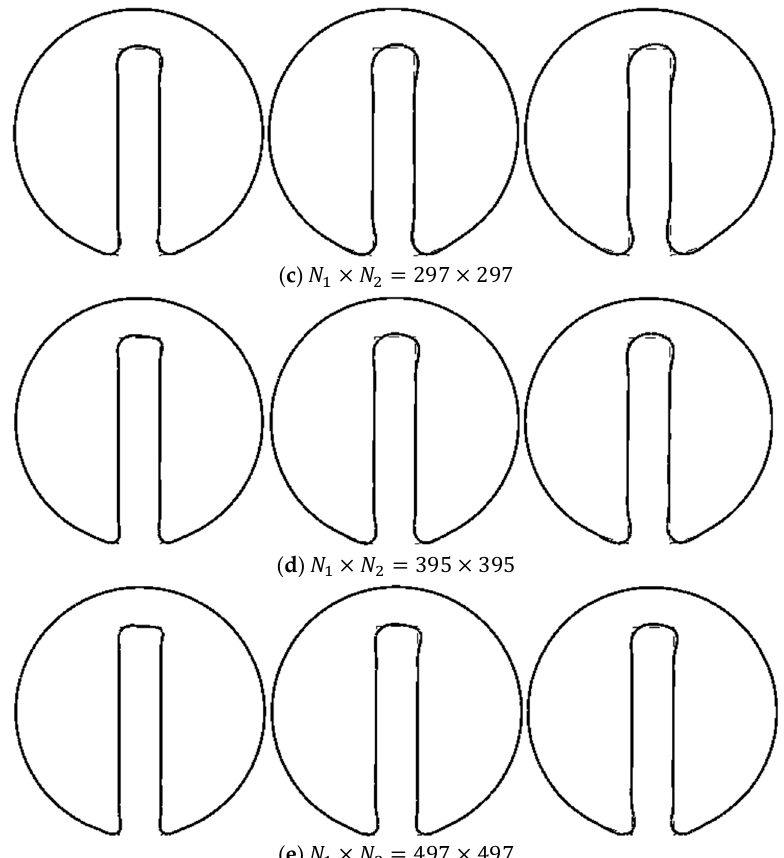
Figure 13. The Notched cylinder after first (left picture), third (middle picture) and fifth (right picture) revolutions with different unstructured mesh spacing. The solid lines show the results after the evolutions and the dashed lines are the original notched cylinder.